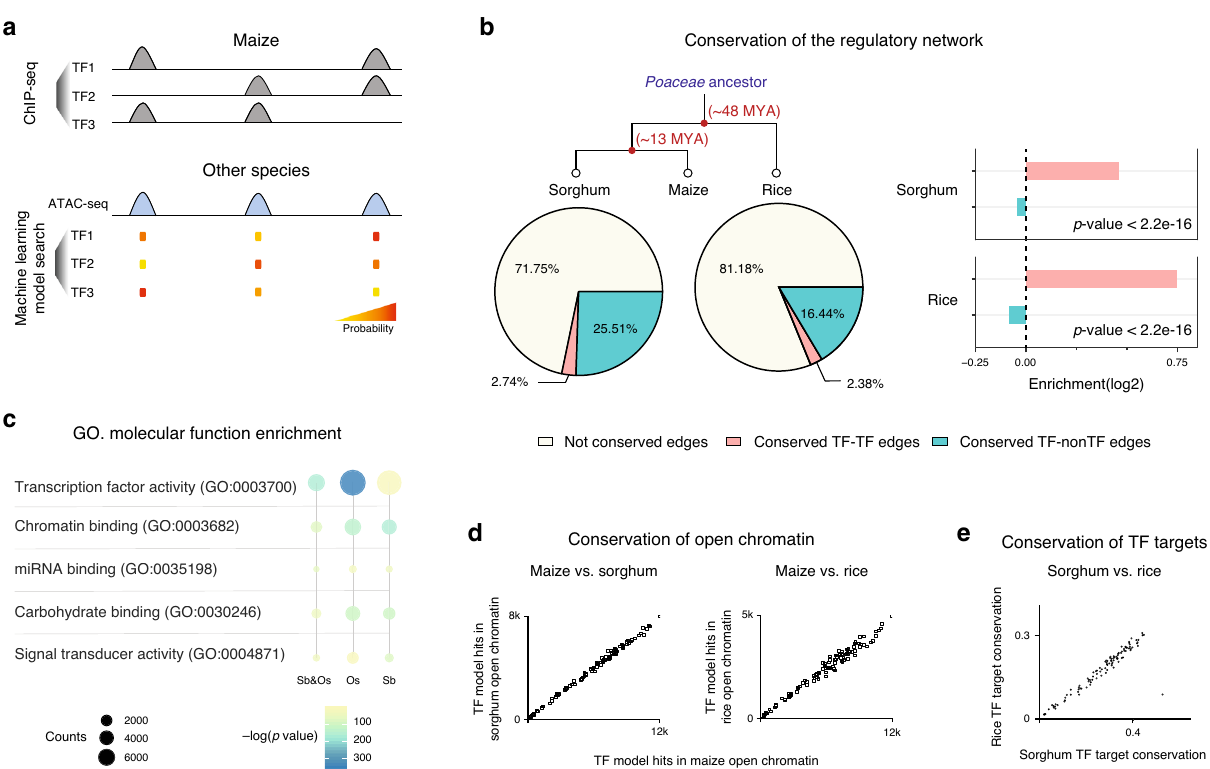
Fig. 7 Conservation of the TF regulatory interactions. a Schematic diagram showing how the TF binding k -mer model is used to search the open chromatin regions of maize synteny gene in other species, to infer conservation of the regulatory interaction. b Pie chart showing percentage of conserved edges in sorghum (left) and rice (right), and bar plot showing TF-to-TF edges are more conserved than TF-to-non-TF edges ( P value; two-sided Fisher exact). c Diagram showing enriched GO-terms for conserved maize TF-target genes. From left to right: conserved in both sorghum and rice, conserved in rice and conserved in sorghum. The size of the circle indicates the number of genes, and the color is scaled to − log10( P val) (two-sided Fisher exact). d Number of recognition sequences of each TF predicted in maize, sorghum, and rice open chromatin. e The axis indicates the percentage of target conservation of each maize TF in rice and sorghum, inferred from the TF model matches in their synteny target gene open